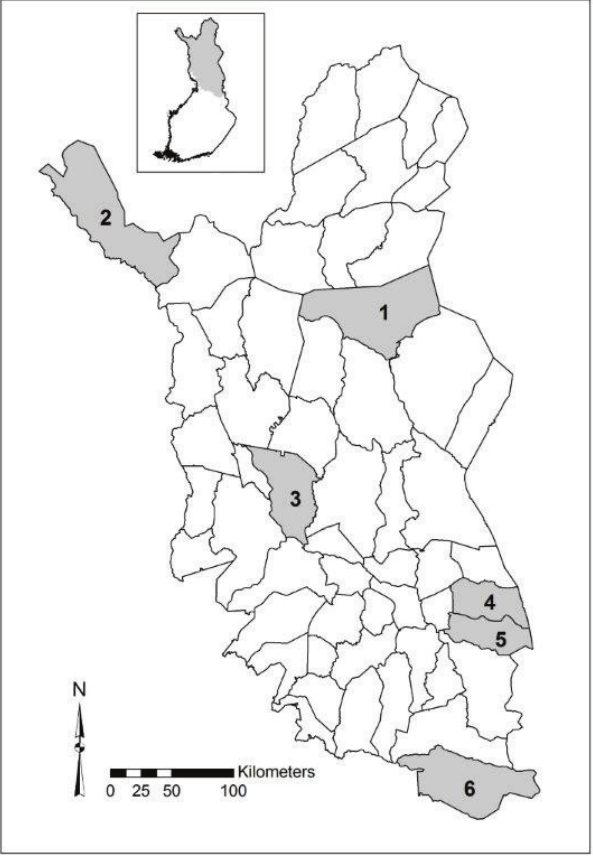
Fig.1. Reindeer-herding cooperatives in the study and Finnish reindeer husbandy area: 1. Ivalo, 2. Käsivarsi,